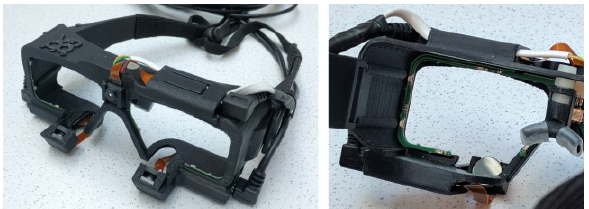
Figure 11. The implemented gaze tracking glasses. There are six LEDs around each eye. The scene camera is lo- cated above the